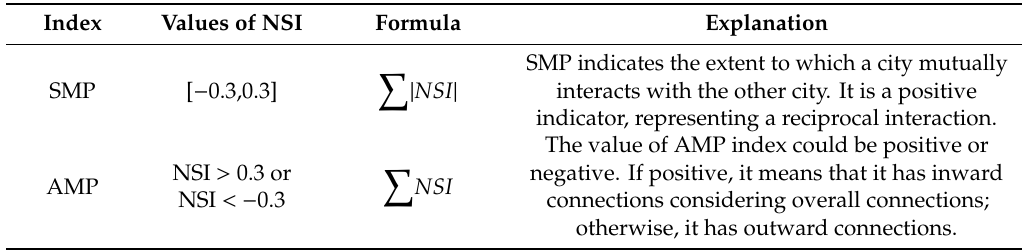
Table 3. Calculation of SMP and AMP indexes.